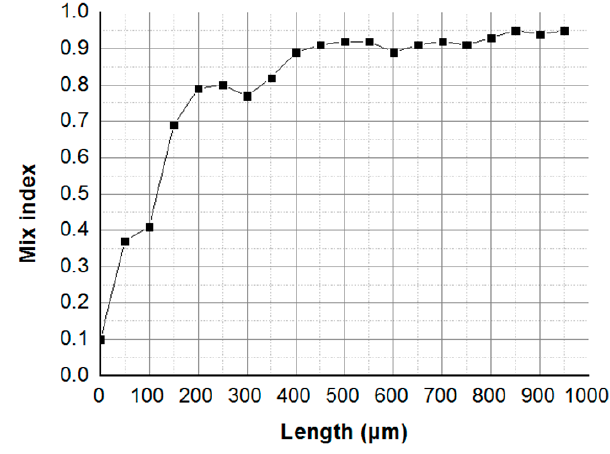
Figure 6. Experimental mixing performance of the helical micromixer: mixing index σ graphics of Figure 5a.